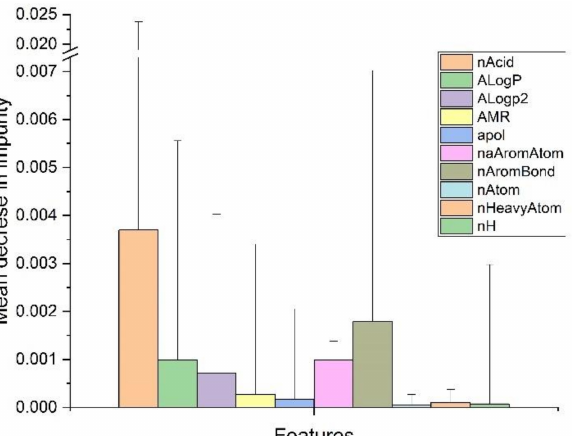
Figure 3. Feature importance (standard deviation) of the first 10 features for random forest classifi- cation; nAcid = number of acidic groups; ALogP = Ghose-Crippen LogKow; ALogP2 = square of ALogP; AMR = molar refractivity; apol = sum of the atomic polarizabilities (including im- plicit hydrogens); naAromAtom = number of aromatic atoms; nAromBond = number of aromatic bonds; nAtom = number of atoms; nHeavyAtom = number of heavy atoms; nH = number of hydro- gen